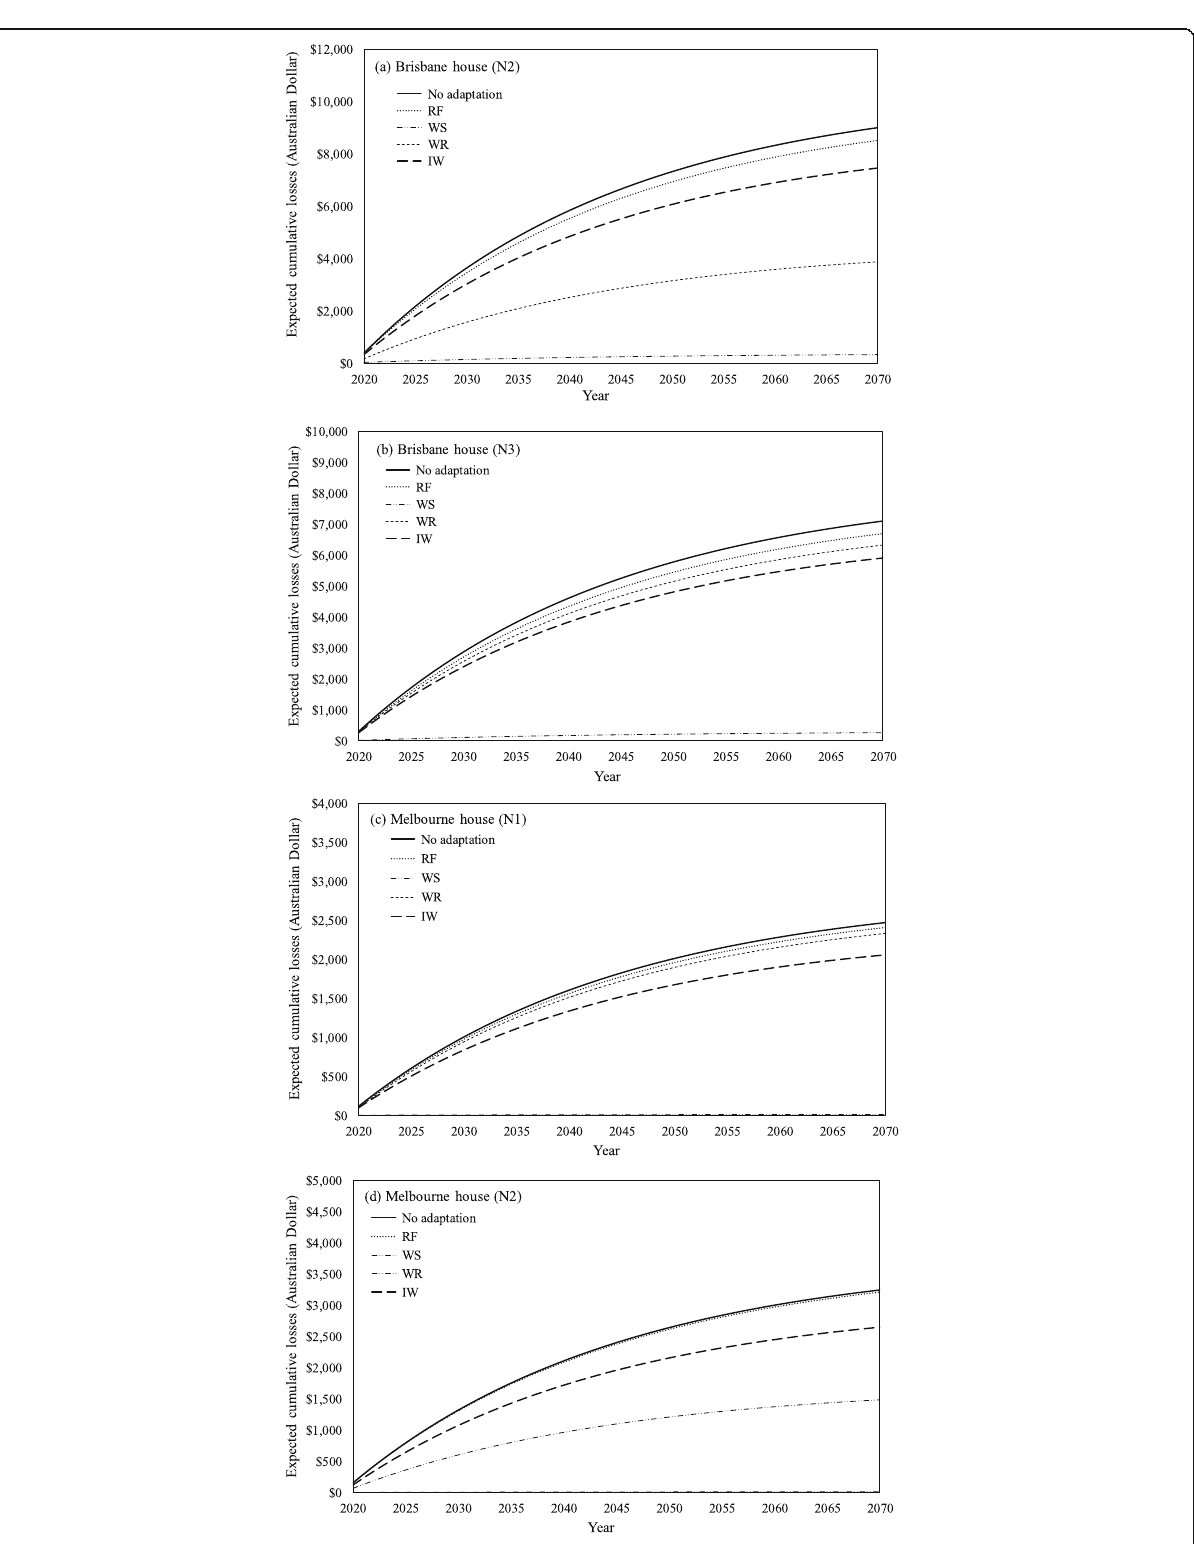
Fig. 11 Cumulative expected losses for houses with construction defects and no climate